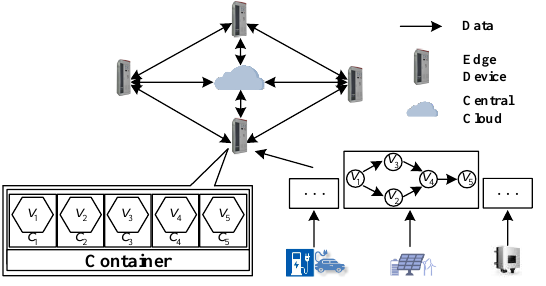
Figure 1. Cloud-edge scheduling mechanism for power tasks under microservice